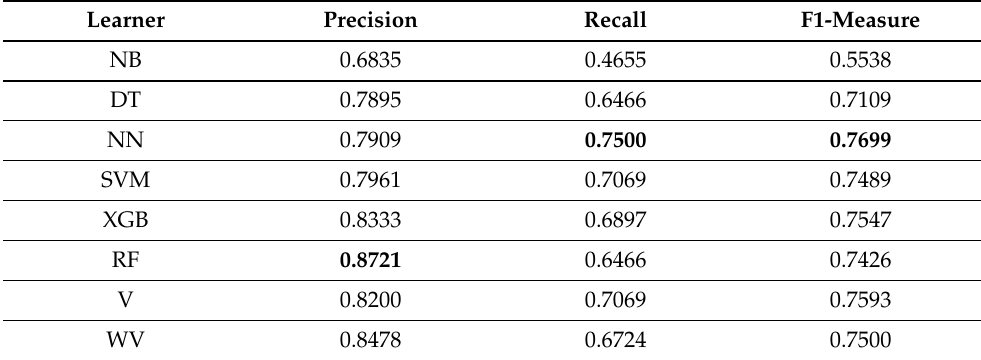
Table 5. Results on manually labeled gold standard, using tweet features only. The best results are marked in bold.